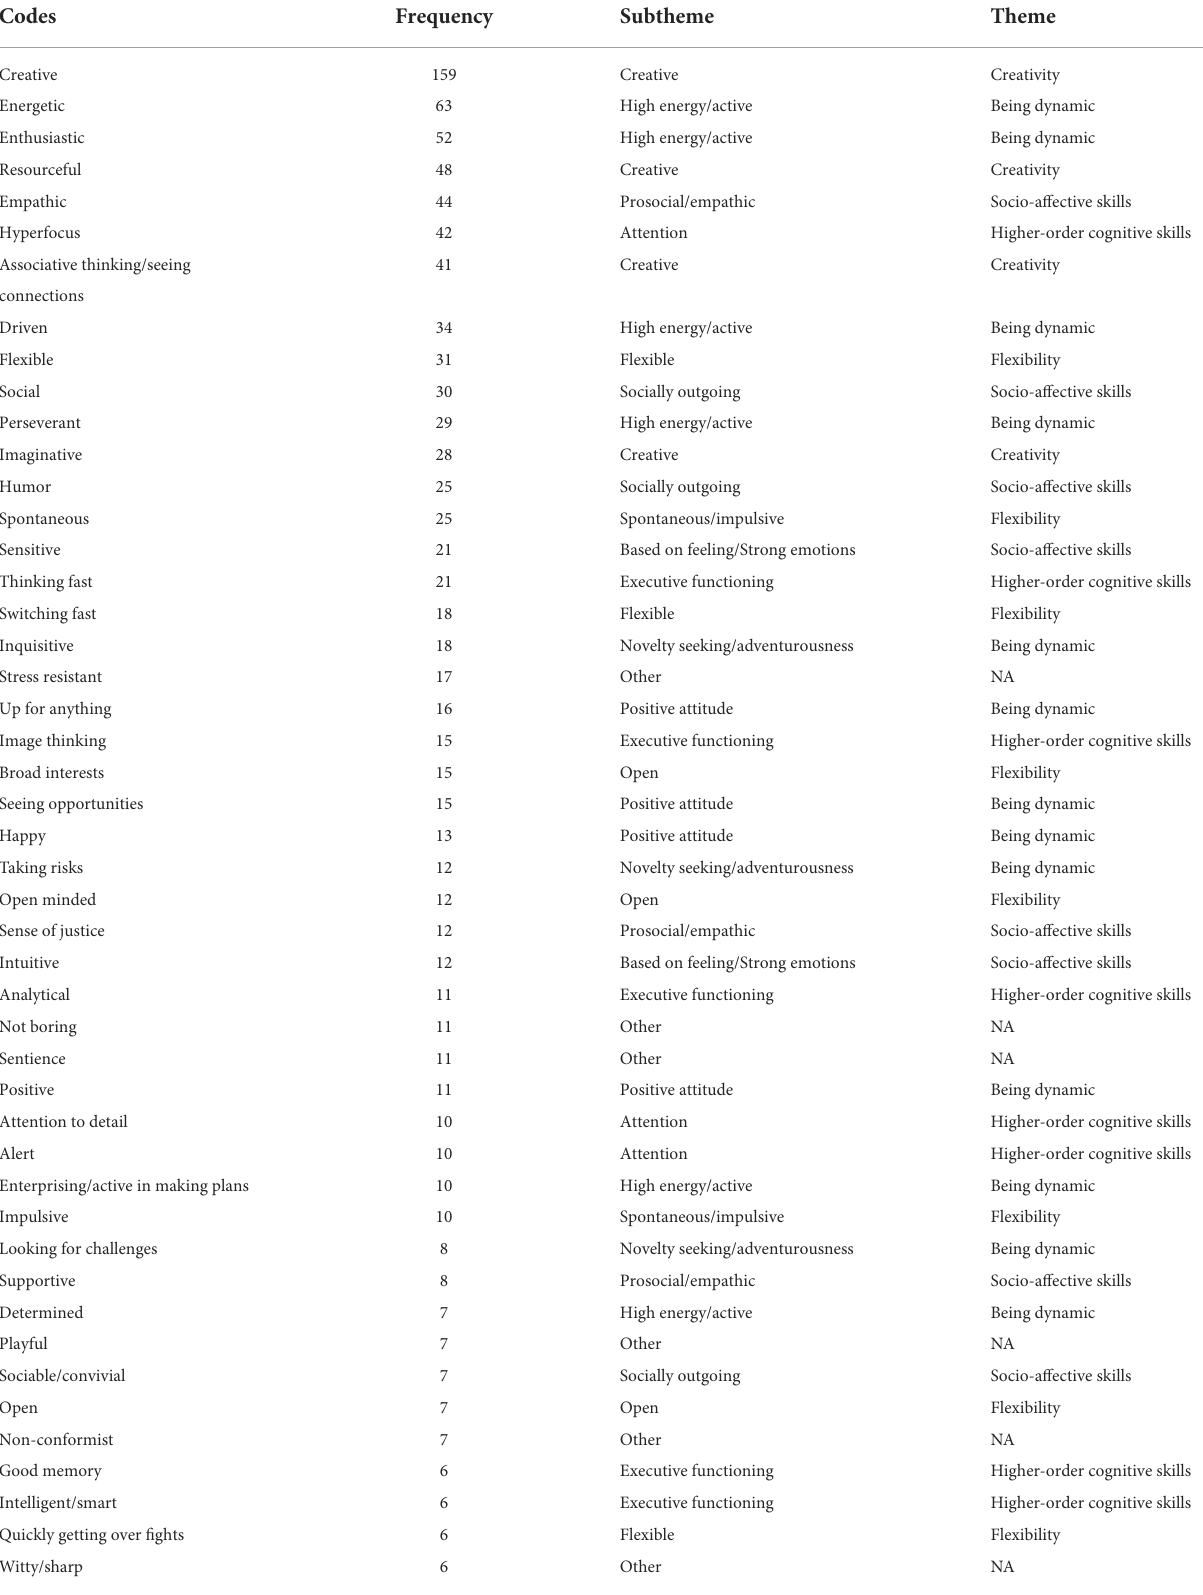
TABLE 3 Codes included in the qualitative analysis, their frequency and corresponding (sub)themes.